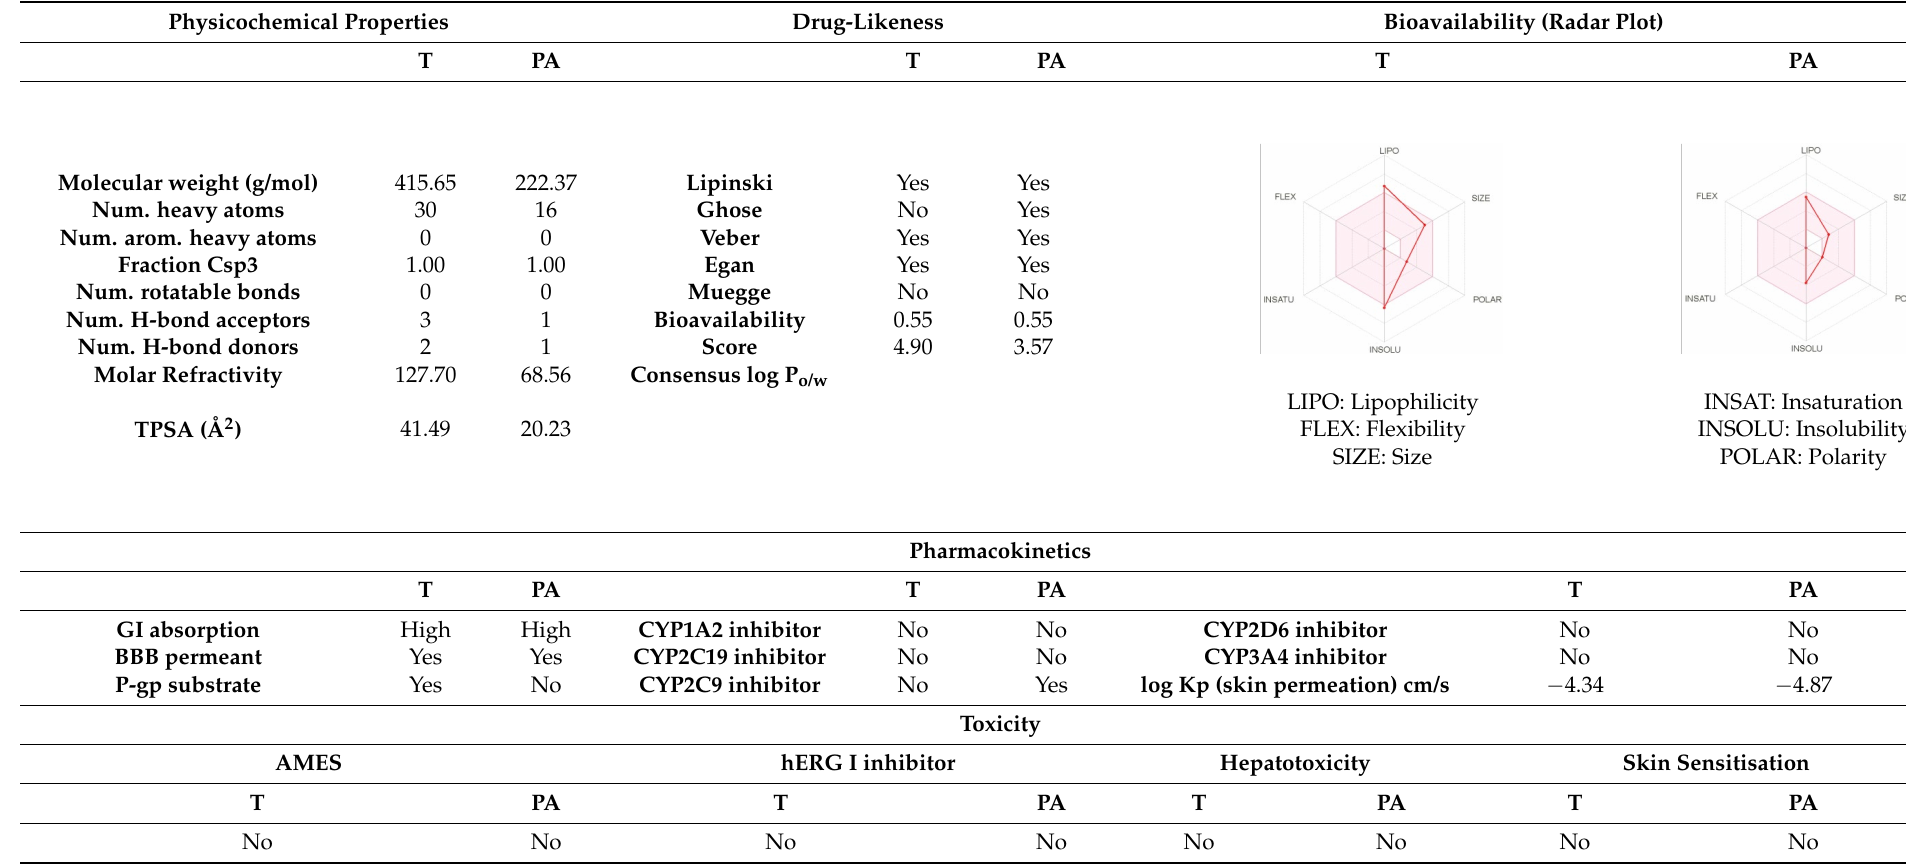
Table 2. Physicochemical properties, drug-likeness, bioavailability, pharmacokinetics and toxicity parameters of tomatidine (T) and patchouli alcohol (PA). Physicochemical Properties Drug-Likeness Bioavailability (Radar